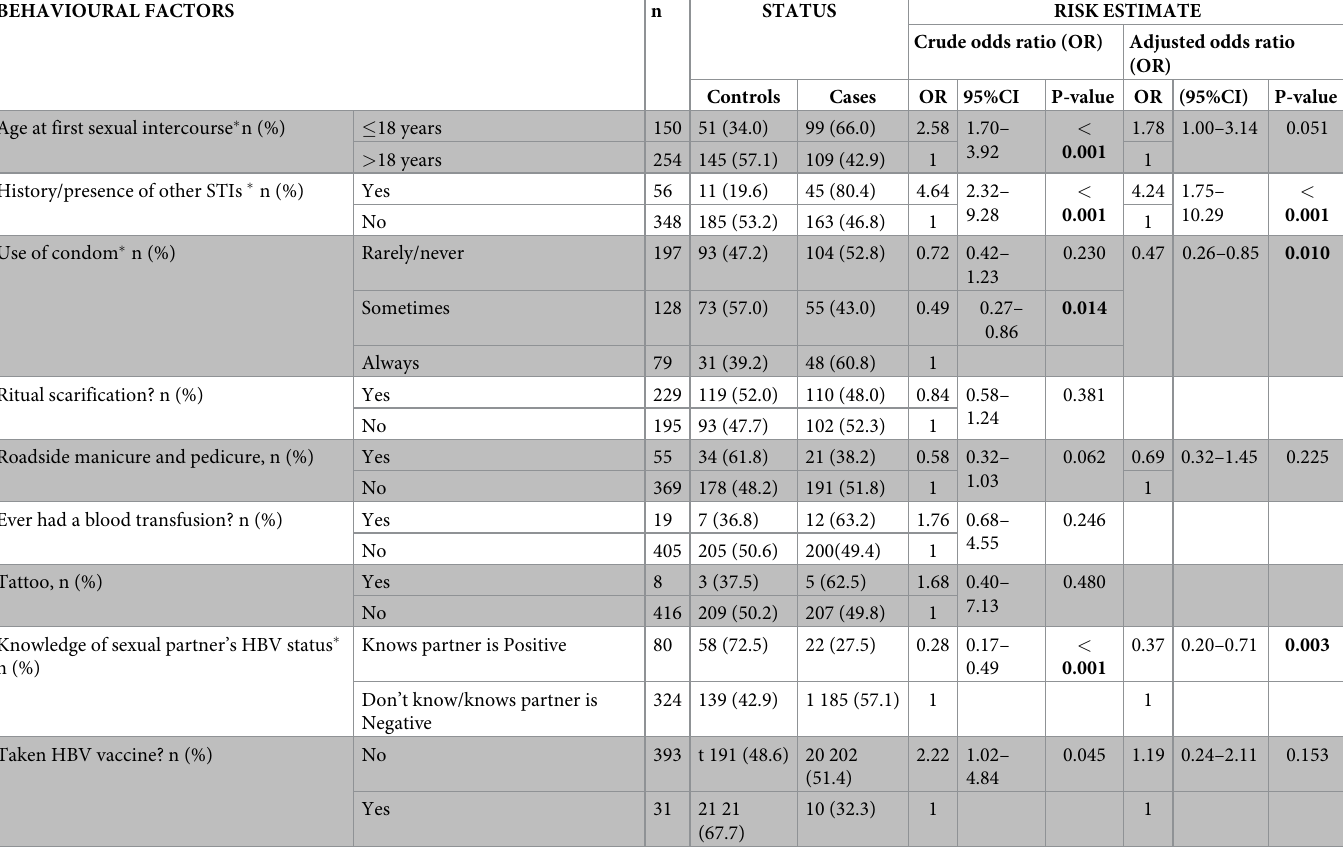
Table 3. Some behavioural factors and their possible association with HBV infection. BEHAVIOURAL